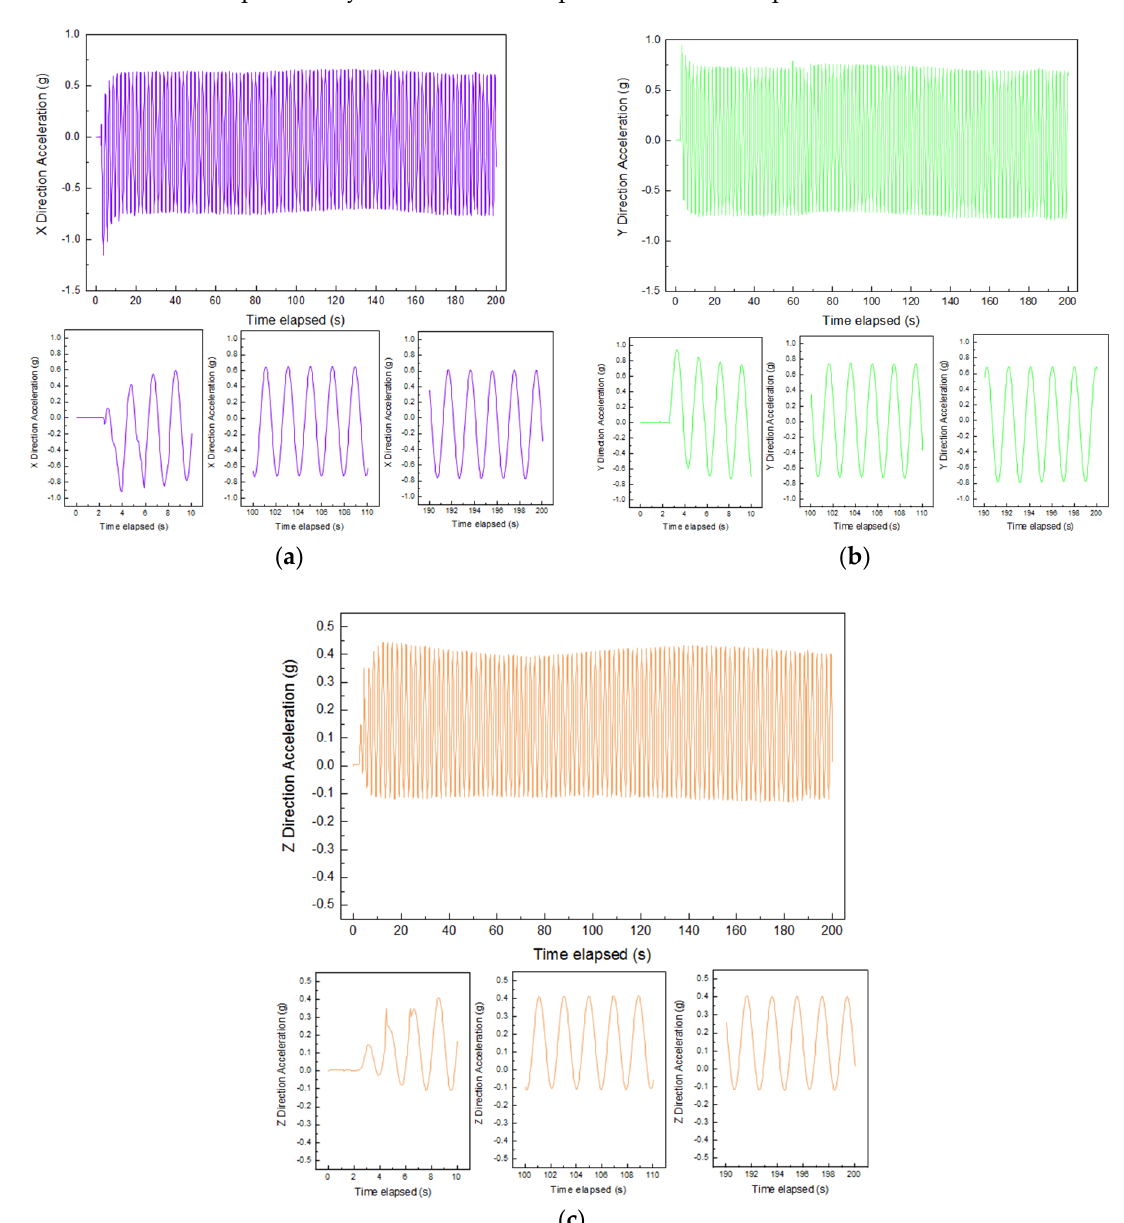
Figure 14. Acceleration results measured in three different directions of at the middle center of the specimen with optimal combination of gyratory parameters: ( a ) X direction, ( b ) Y direction, and ( c ) Z direction.